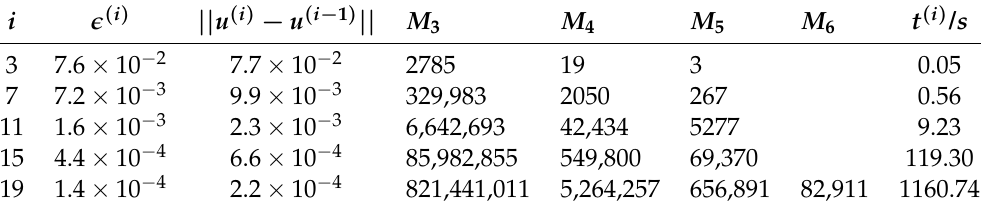
Table 2. Behavior of MLMC gradient projection-based optimization ( σ =